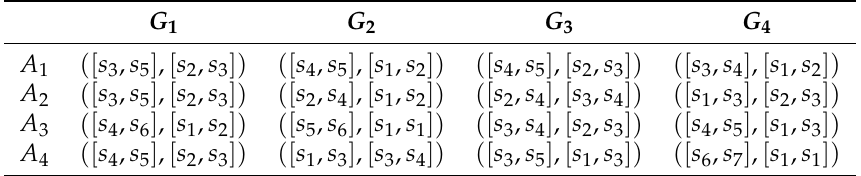
Table 1. Linguistic interval-valued intuitionistic fuzzy decision matrix (cid:101) R ( 1 ) of decision-maker D ( 1 ) . G 1 G 2